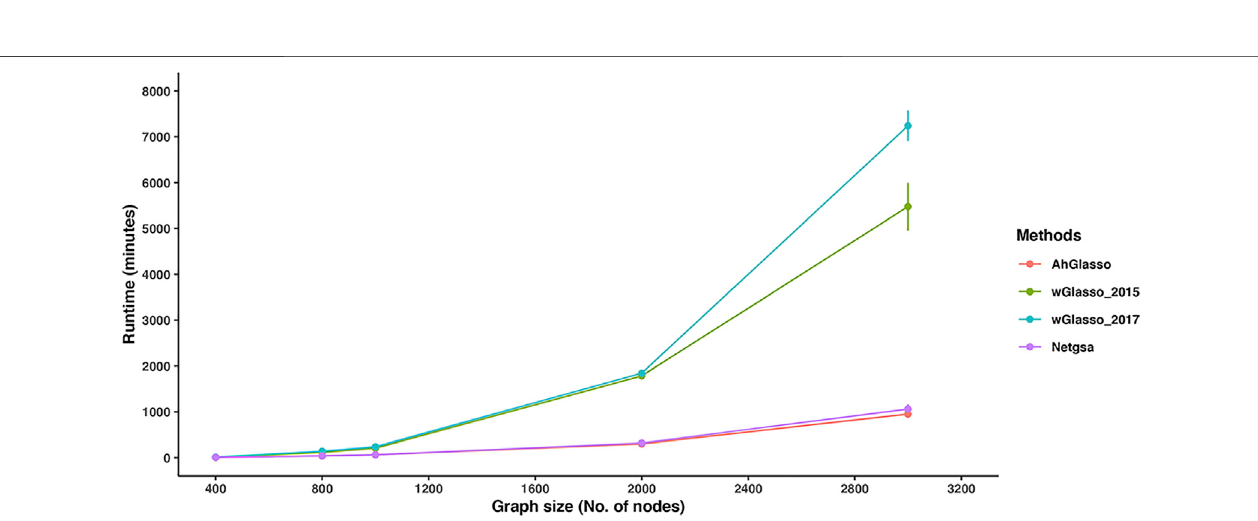
FIGURE 6 | Method runtime comparisons. To compare the computational ef fi ciency of the two weighted graphical Lasso (wGlasso_2015 and wGlasso_2017), Netgsa,andtheproposedAhGlassomethodinthehigh-dimensionalsetting,wesimulateddatasetswitha fi xedsamplesize( n (cid:1) 200)and4 % graphdensity,butvarious graph size ( p varies from 400 to 3000). We compared the total run time of parameter tuning (CV was removed if involved for fair comparisons) and the fi nal model fi tting withthechosenparameter.The λ minimalratiowassetto0.01and40 λ candidatesweresearched.Thesimulationwasrepeated5timesforeachsetting.Thelines represent the mean runtime for the simulated graph size and the error bars represent the standard error of the mean for each method.